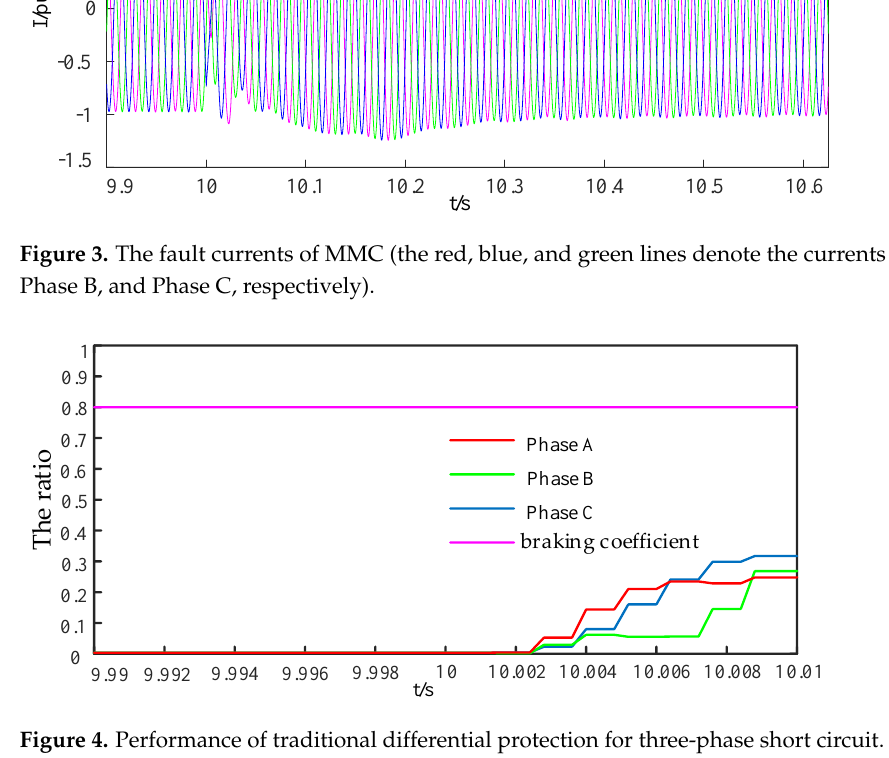
faults are shown in Figure 5. Figure 4. Performance of traditional differential protection for three-phase short circuit.